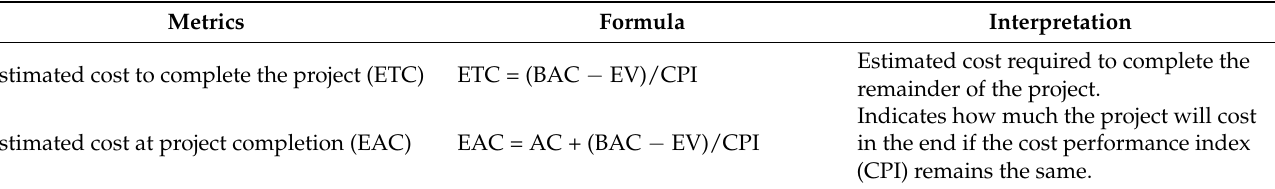
Table 3. Forecast indicators in the EVM technique [30].